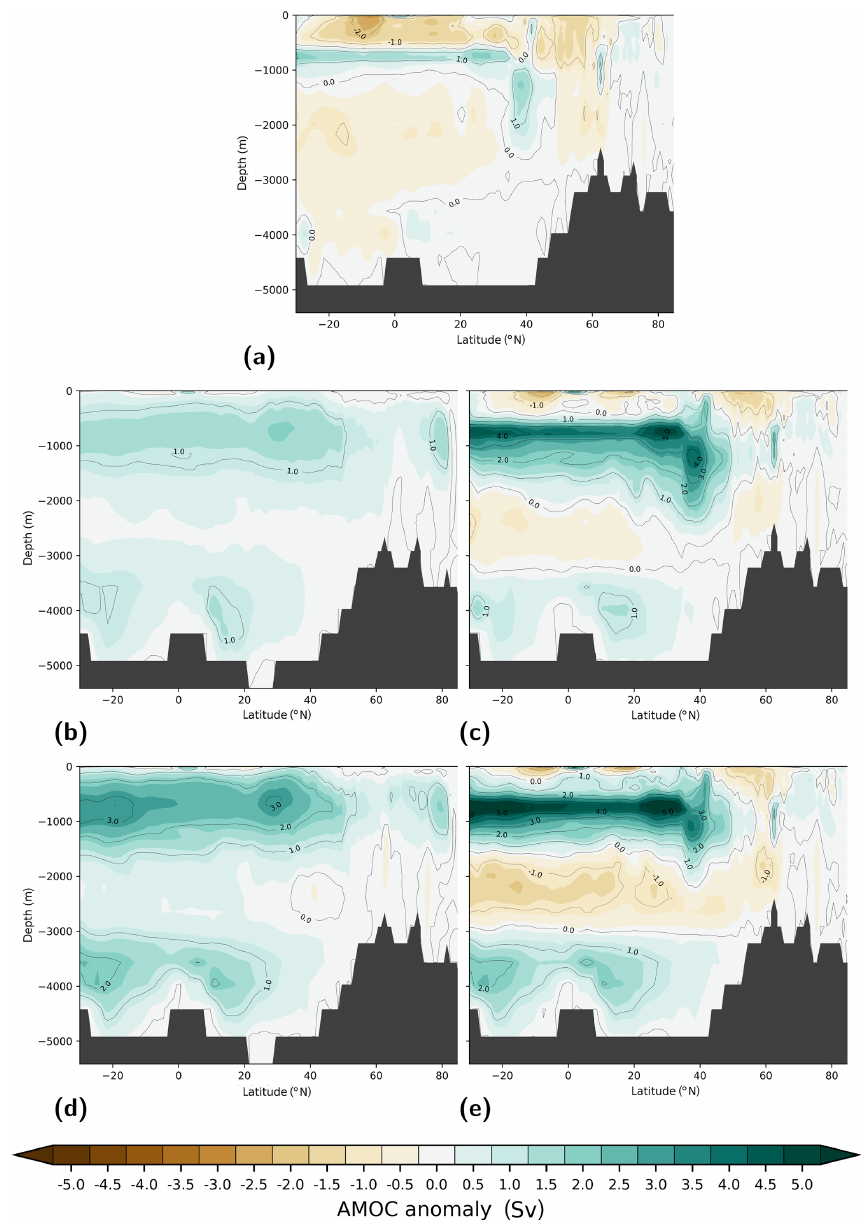
Figure 7. Atlantic Ocean Meridional Overturning Circulation (AMOC) anomaly with respect to pre-industrial (E280) in Sverdrups (1Sv ≡ 10 6 m 3 s − 1 ) visualised via the basin-wide zonal- and time-integrated stream function. Shown are (a) Eoi280, (b) E400, (c) Eoi400, (d) E560, and (e) Eoi560. Positive AMOC anomalies illustrate a change towards clockwise circulation from the viewpoint of Europe and Africa. Dark grey shading illustrates bottom topography zonally averaged across the